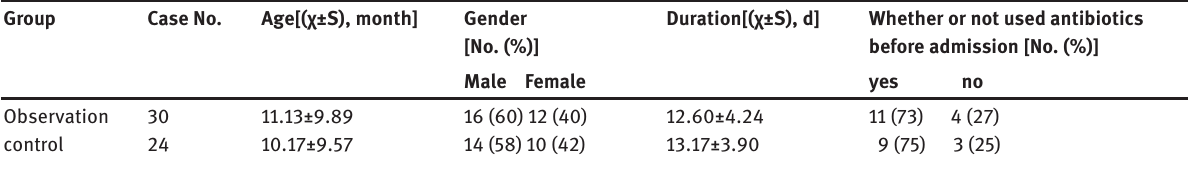
Table 1: Comparison of general information of the two groups. Group Case